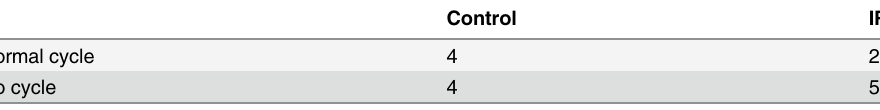
Table 3. Estrous cycle after 3 months HFD